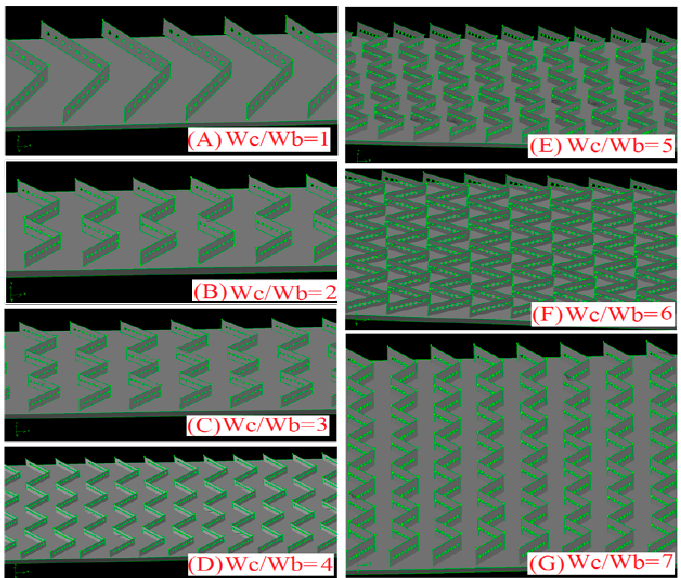
Figure 2. Computational domains for the CFD analysis. ( A ) Wc / Wb = 1; ( B ) Wc / Wb = 2; ( C ) Wc / Wb = 3; ( D ) Wc / Wb = 4; ( E ) Wc / Wb = 5; ( F ) Wc / Wb = 6; and ( G ) Wc / Wb = 7. Table 3. Range of operating parameters for CFD analysis.